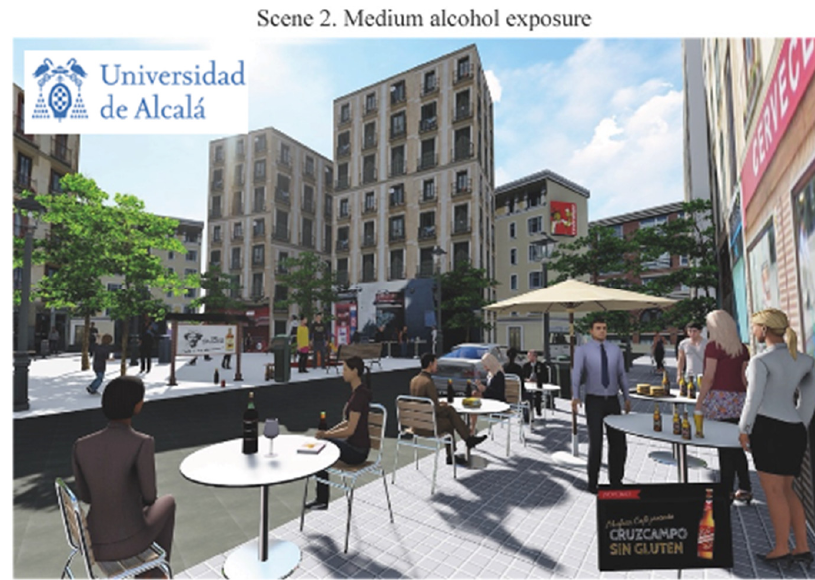
Figure 5. Medium alcohol exposure scenario.